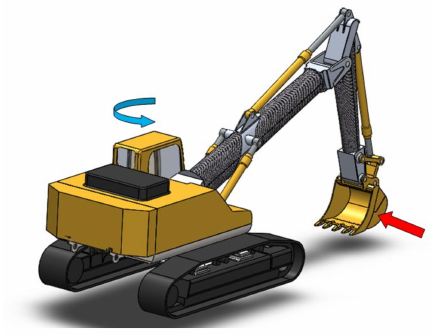
Figure 5. Load condition